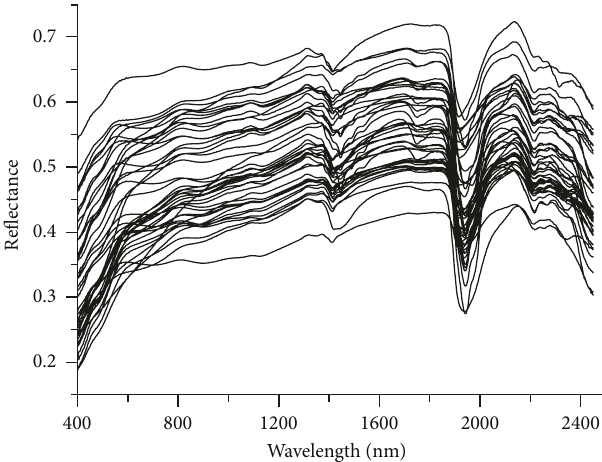
Figure 2: Spectral re fl ectance of soil samples after smoothing.